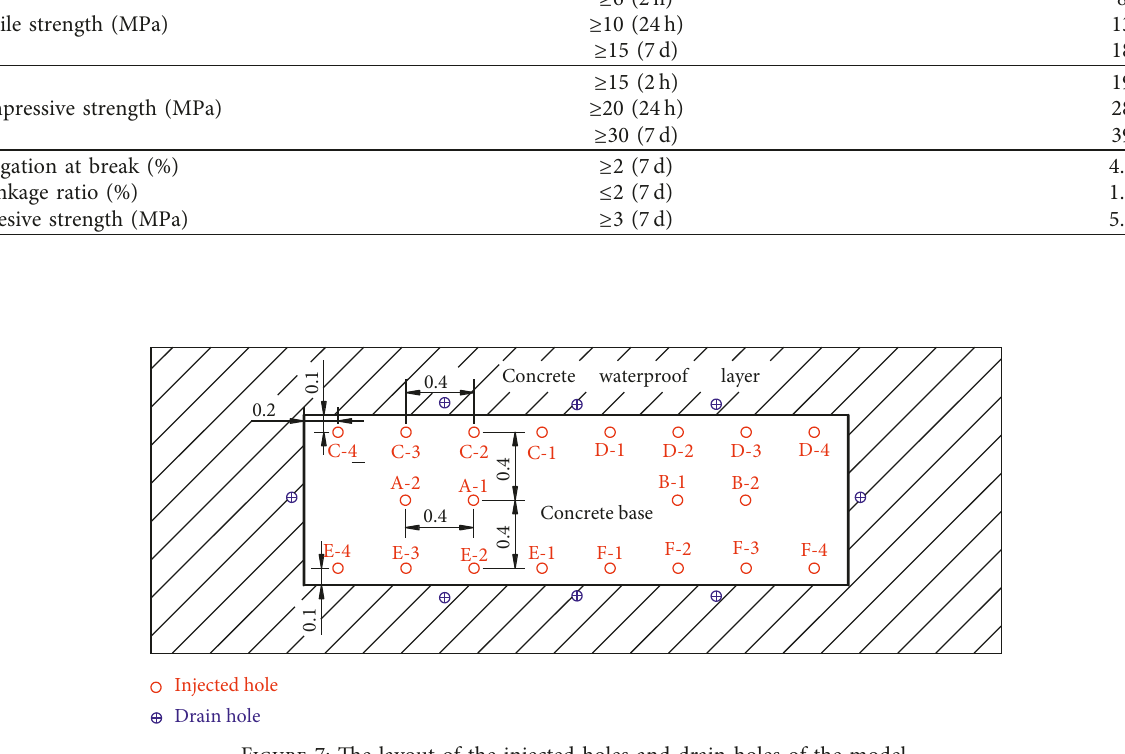
Figure 7: The layout of the injected holes and drain holes of the